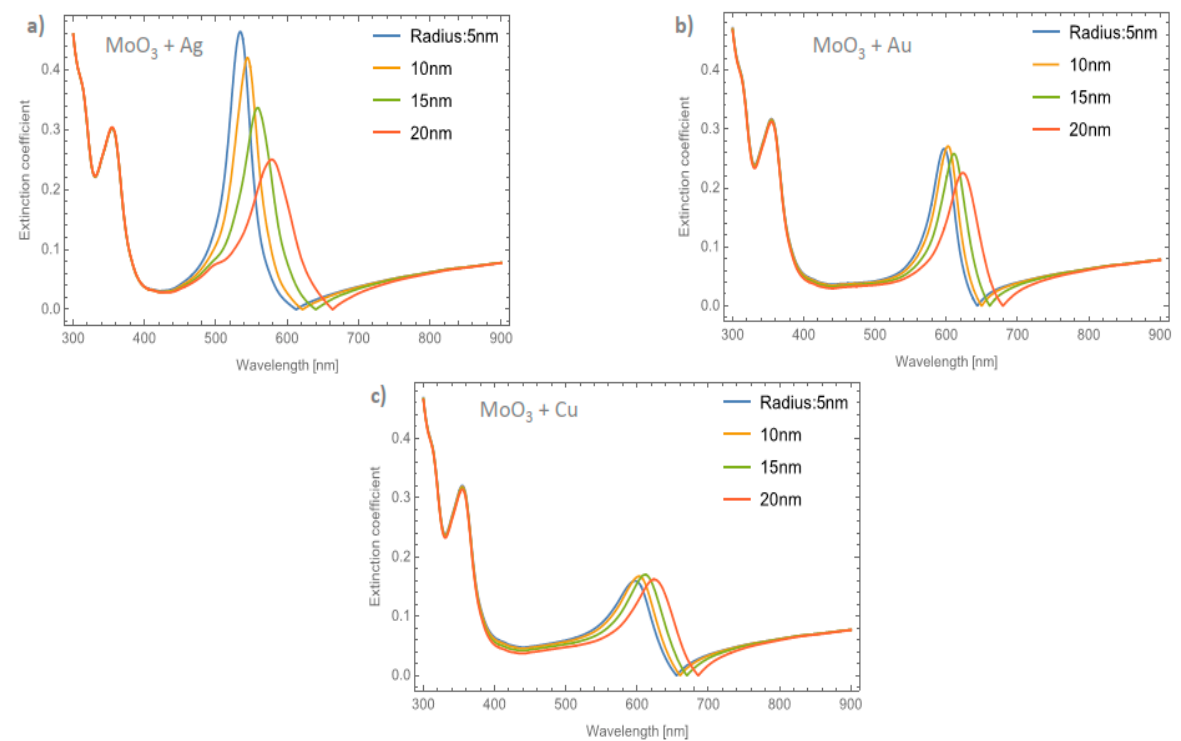
Figure 6. The extinction coefficient of the MoO 3 thin film doped with ( a ) Ag ‒ NPs, ( b ) Au ‒ NPs, and ( c ) Cu ‒ NPs for a volume filling fraction of 1%. In all spectra, the thickness was fixed to a value of 120 nm, and different NPs radii are labeled.